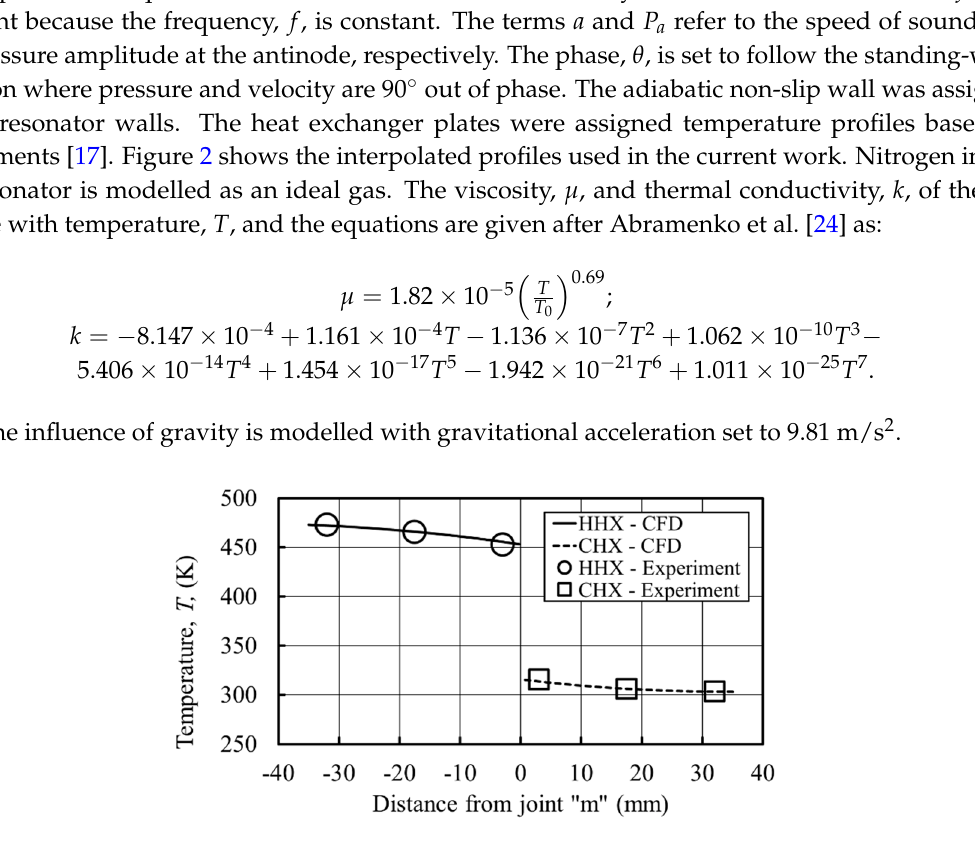
Figure 2. Temperature profiles applied to cold and hot heat exchangers based on experimental points. CHX—cold heat exchanger; HHX—hot heat exchanger; CFD—computational fluid dynamics.